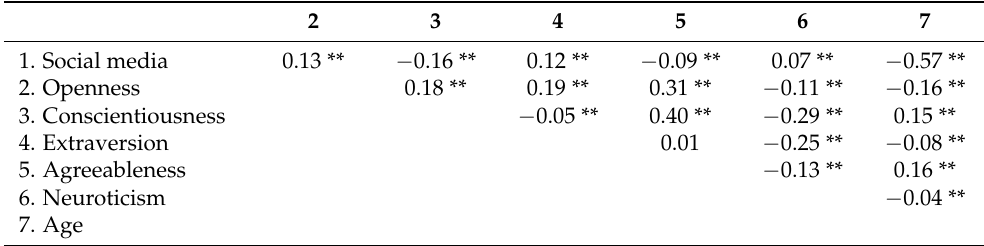
Table 1. Intercorrelations of study variables: social media usage, Big Five (HP5i), age. 2 3